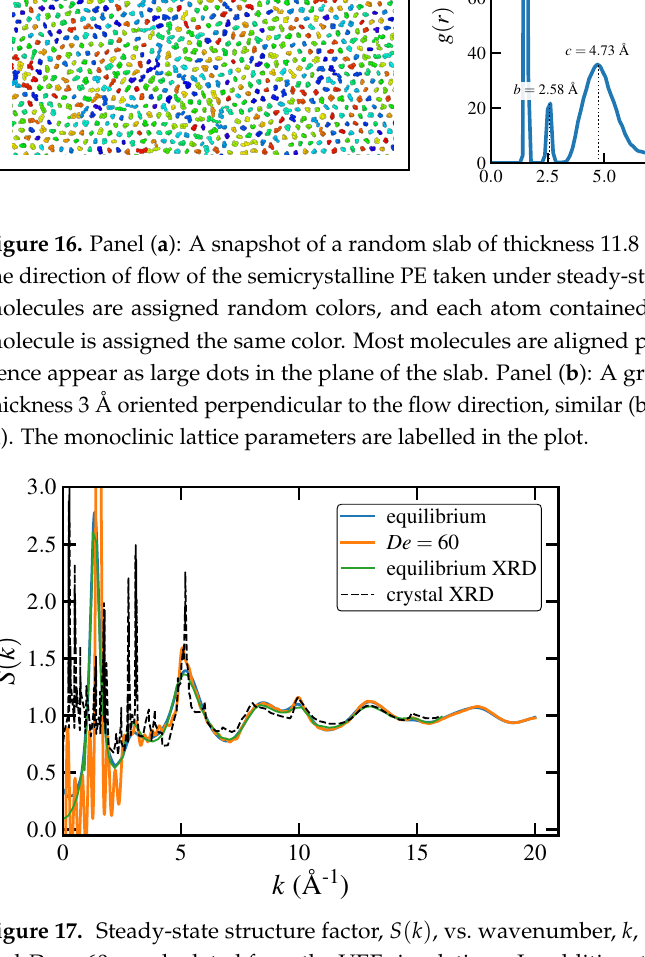
Figure 17. Steady-state structure factor, S ( k ) , vs. wavenumber, k , of the C 1000 H 2002 melt at De = 0 and De = 60 as calculated from the UEF simulations. In addition, there are the structure factors for an n-eicosane liquid (labelled as ‘equilibrium XRD’ in the legend) and solid crystal as obtained from X-ray diffraction